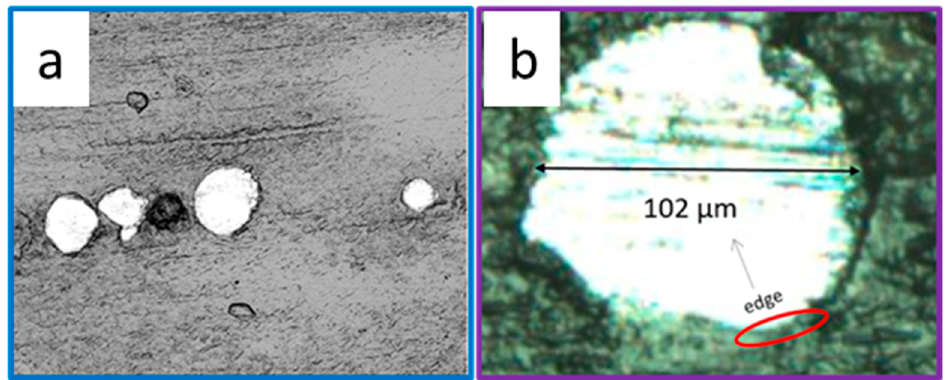
Figure 6. Scanning electron microscope (SEM) images of the composite ( a ) and its zoom-in view of the particle region ( b ).